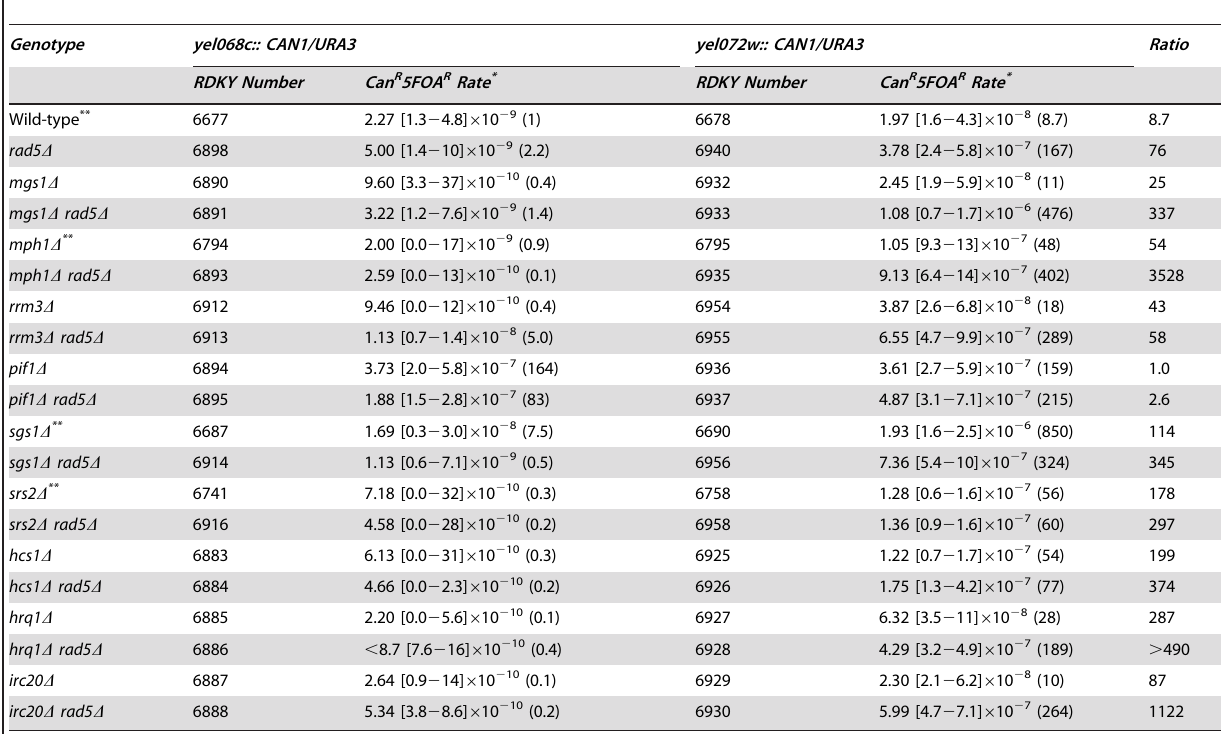
Table 5. Effects of combining defects in RAD5 with other helicase-encoding genes on duplication-mediated GCRs.